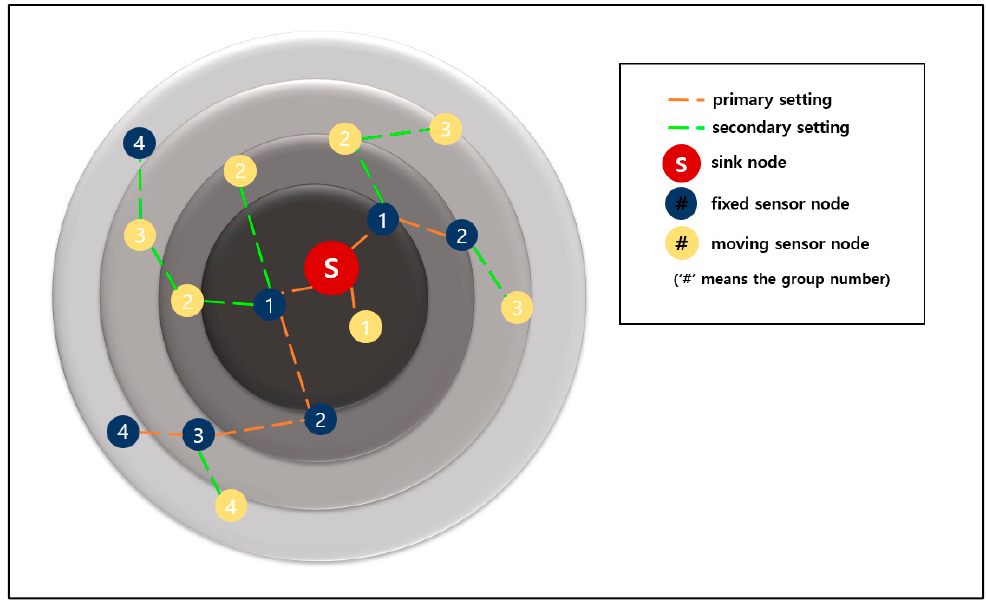
Figure 13. Primary and secondary settings of node group numbers.